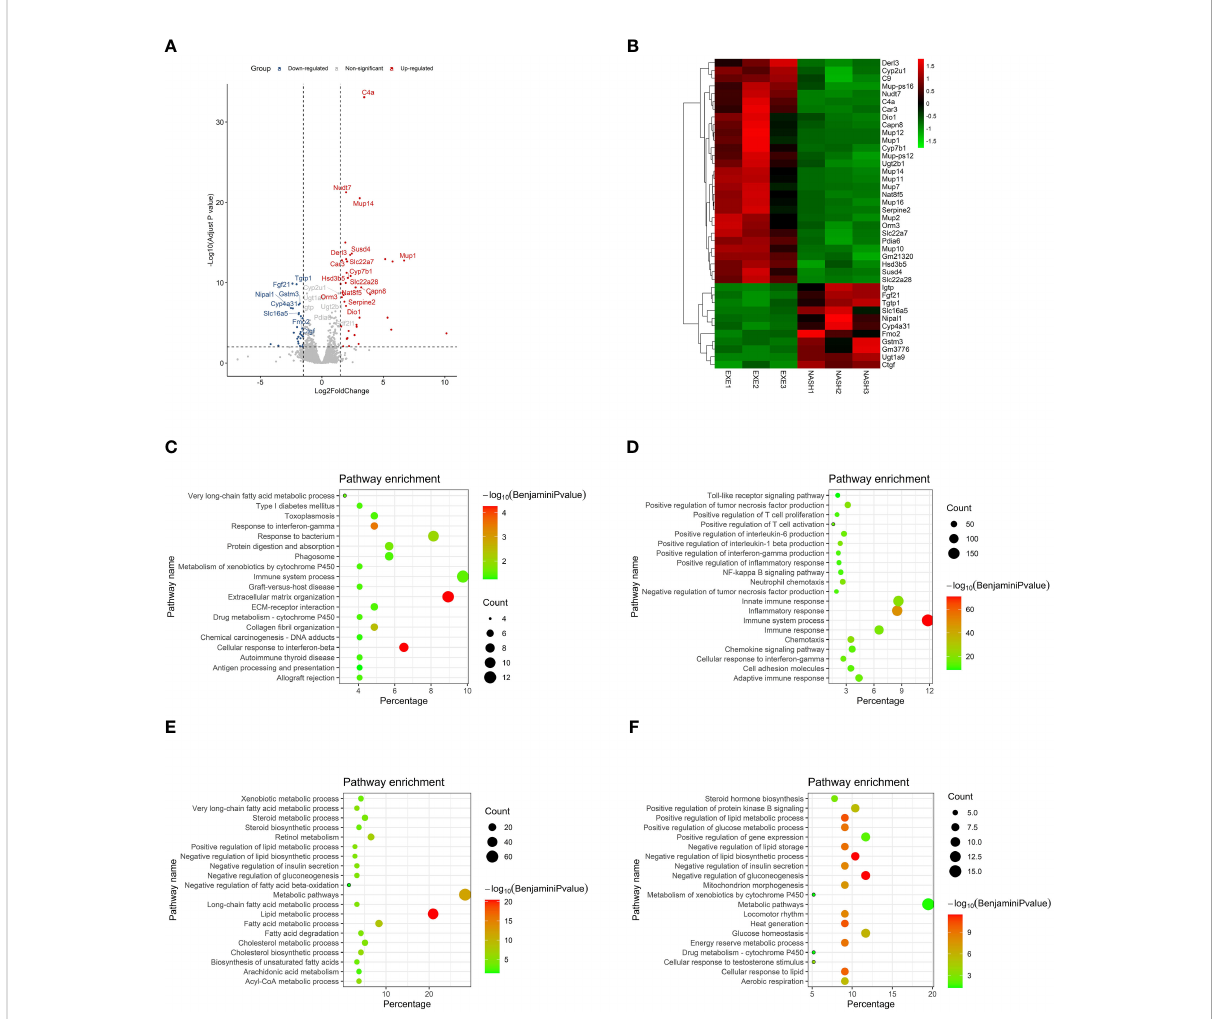
FIGURE 3 Transcriptomic analyses suggested that aerobic exercise ameliorated hepatic in fl ammation, lipid abnormity and fi brosis in NASH mice. (A) Volcano map of differentially expressed genes in the transcriptomic analyses. (B) Heatmap in the transcriptomic analyses comparing NASH mice with NASH+Exercise mice. (C) GO enrichment analyses of those crucial down regulated genes in NASH+Exercise mice compared with NASH mice. The signi fi cance of enrichment was expressed by the log10 value of Benjamini adjusted P value together with the color transition from white to red. The gene number was for the number of enriched genes in certain functional pathway, while the percentage was for the proportion of enriched genes among total genes in certain functional pathway. (D) GO enrichment analyses of those crucial up regulated genes in NASH mice compared with controls. (E) GO enrichment analyses of those crucial down regulated genes in NASH mice compared with controls. (F) GO enrichment analyses of those crucial up regulated genes in NASH+Exercise mice compared with NASH